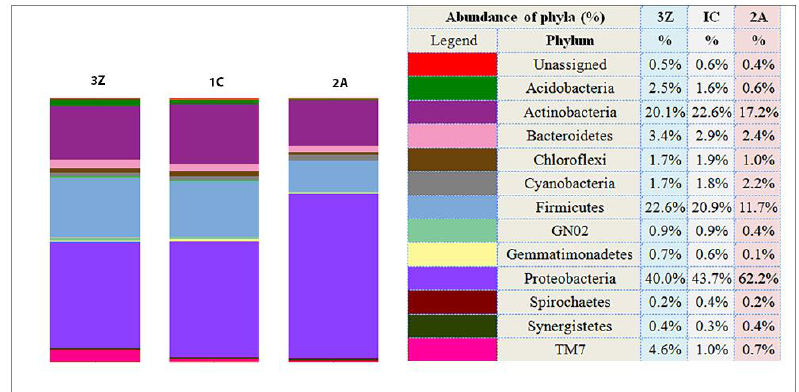
Figure 3. Relative abundance of bacterial phyla. The figure and the accompanying table indicate relative abundance (%) of bacterial phyla in treated and untreated soil samples. 1C—control